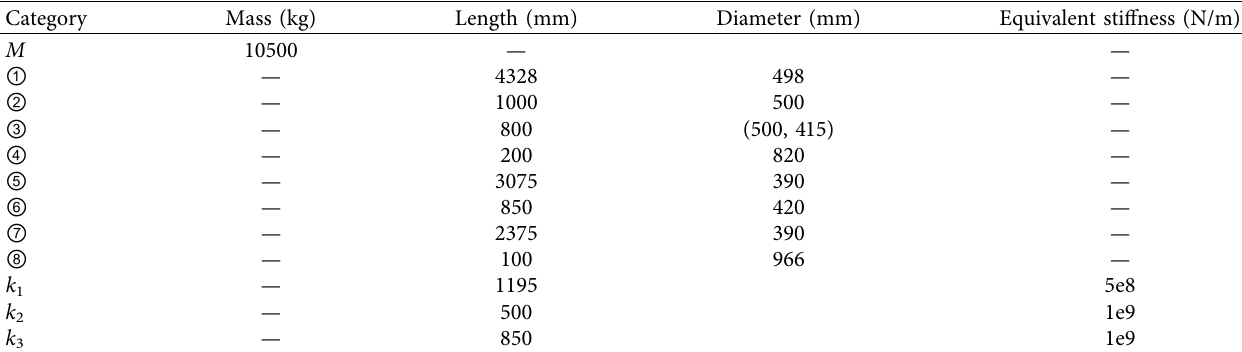
Table 1: The specific parameters of the propulsion